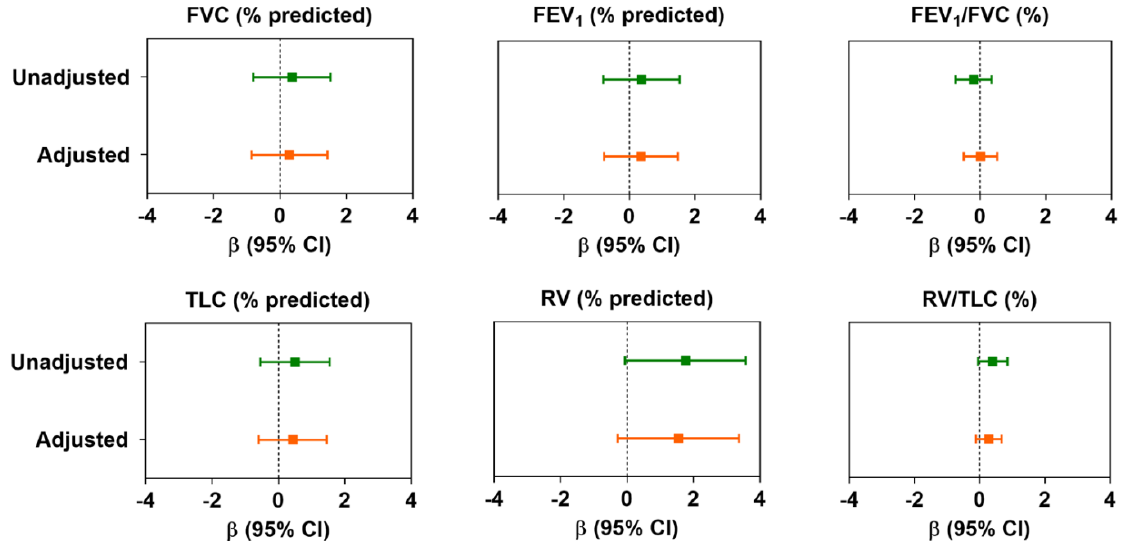
Figure 2. Changes in lung function in association with per interquartile (IQR) change in air pollution index. Data presented as linear regression coefficient ( β ) and 95% confidence interval, unless otherwise specified. Coefficients were calculated with respect to per IQR change ( μg/m 3 ) of air pollution index (principal component). In adjusted models, age, sex, BMI, race, and smoking history were considered as confounders. For abbreviations, see text.